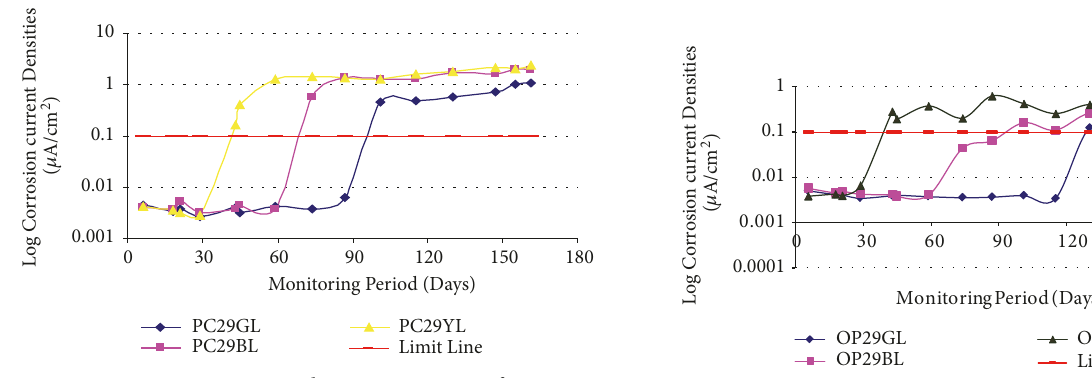
Figure 3: Corrosion potential versus time for OPC at w/c of 0.85.